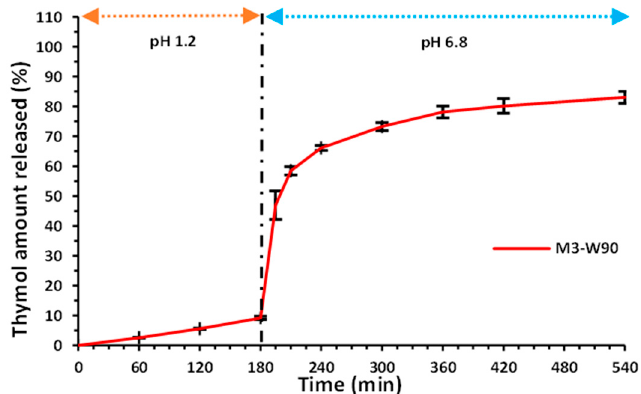
Figure 3. The dissolution profile of coated pellets M3-W90 (pH 1.2 and pH 6.8, without polysorbate 80).